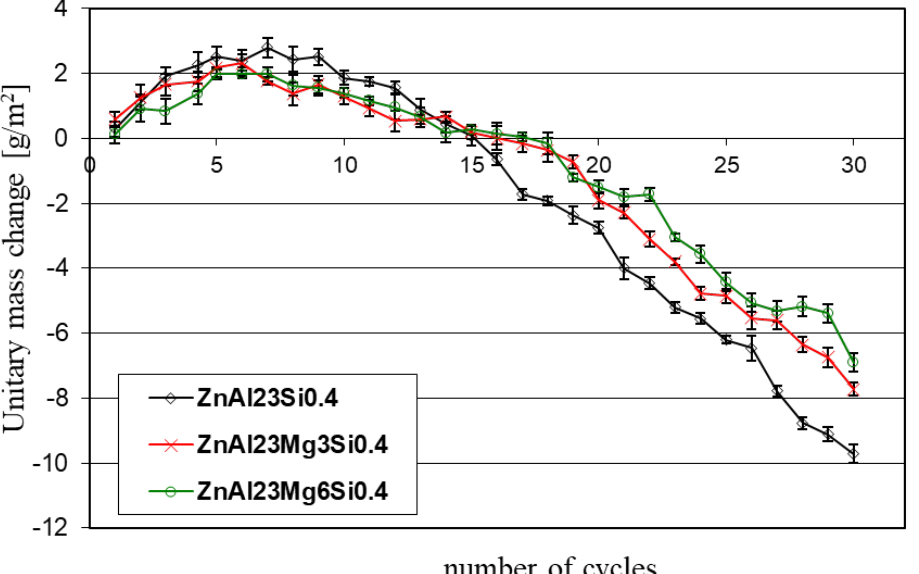
Figure 10. Dependence of unitary changes in the mass of coatings obtained in the research baths during the sulfur dioxide in a humid atmosphere